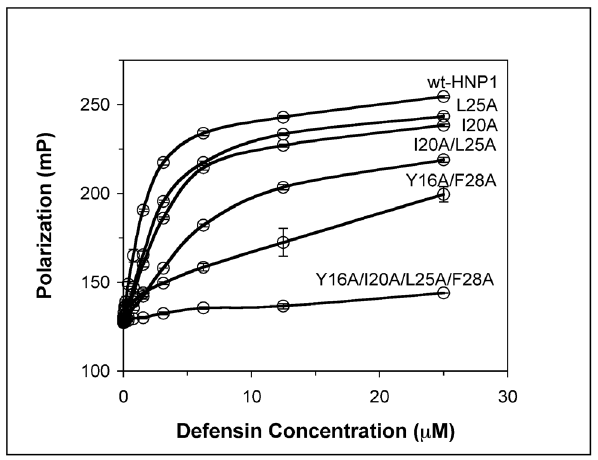
Figure 8. Defensin binding to N36 peptide as determined by fluorescence polarization. An increase in fluorescence polarization is indicative of defensin binding to fluorecently labeled N36 peptide. The curves are obtained from the averages of three measurements.